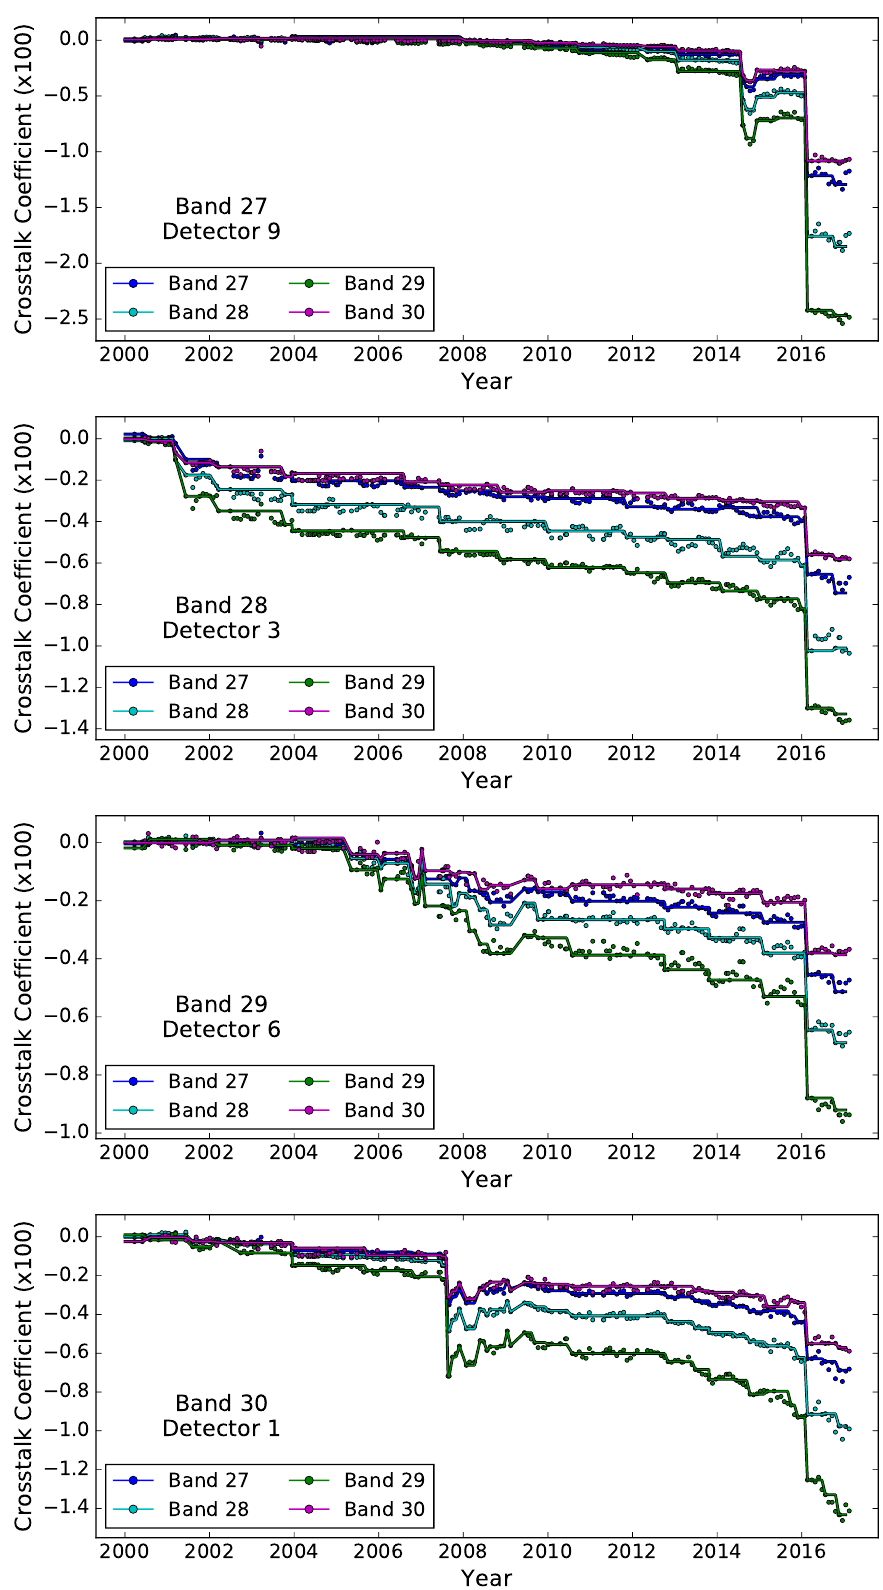
Figure 4. Example of the trending coefficient values derived from lunar observations. The circles represent the coefficients derived from individual lunar observations. The lines show the coefficient values used in Collection 6, based on the criteria described in Section